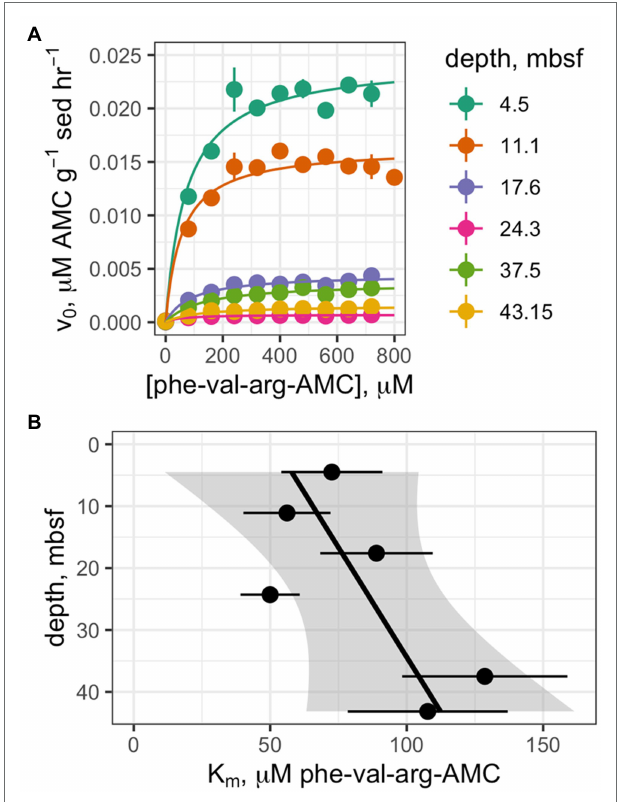
FIGURE 4 | (A) Saturation curves of Z-phe-val-arg-AMC (clostripain substrate) at six depths. (B) Trend of K m values as a function of depth.